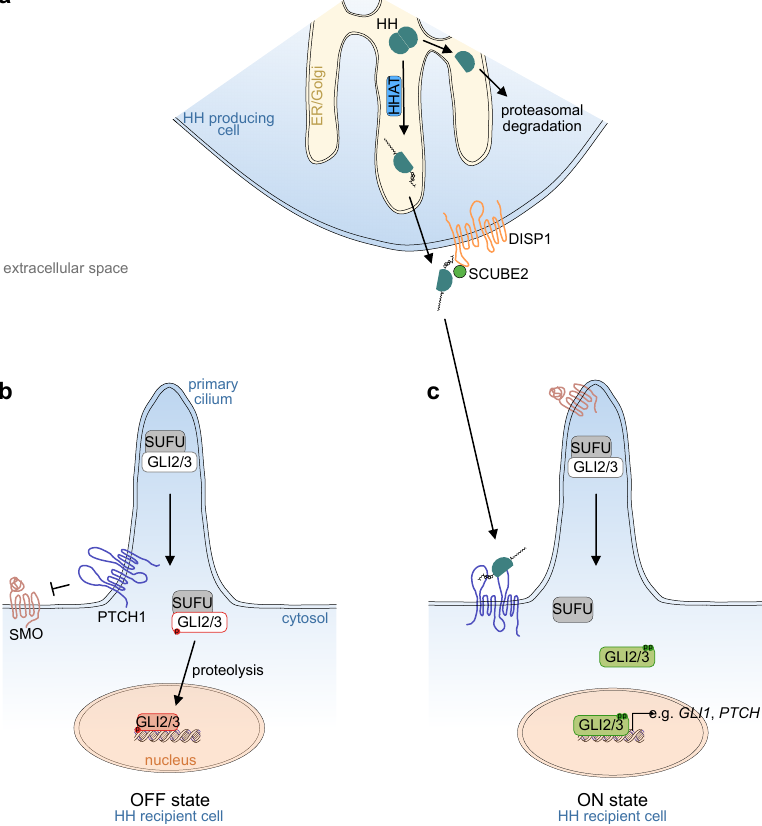
Figure 1. Essential molecules of the mammalian Hedgehog signaling pathway and their interactions. ( a ) In the producing cell, Hedgehog (Hh) ligands are formed as precursor proteins and undergo posttranslational modification within the endoplasmatic reticulum (ER) and Golgi apparatus. The C-terminus is cleaved and degraded by the proteasome. The former N-terminus is palmitoylated and conjugated with a cholesterol moiety by Hh acetyltransferase (HHAT), as well as autocatalytically. Secretion is facilitated by cell membrane-residing Dispatched 1 (DISP1) and its cofactor SCUBE2. ( b ) In the absence of Hh ligands, Patched 1 (PTCH1) prevents Smoothened (SMO) from entering the primary cilium. Full-length Glioma-associated oncogenes 2 and 3 (GLI2/3) transcription factors accumulate within the primary cilium in a complex with Suppressor of fused (SUFU). GLI2/3 factors are phosphorylated at their repressor domains, triggering proteolytical cleavage into truncated repressor proteins, which can enter the nucleus and inhibit the expression of Hh target genes (GLI2/3 in red). ( c ) Hh ligands interact with PTCH1, which releases repression of SMO. SMO accumulates at the top of the primary cilium and full-length GLI2/3 is released from its inhibitor SUFU. GLI2/3 are further phosphorylated at their activator domains. The activated proteins (GLI2/3 in green) enter the nucleus and activate the expression of Hh target genes, including GLI1 and PTCH1